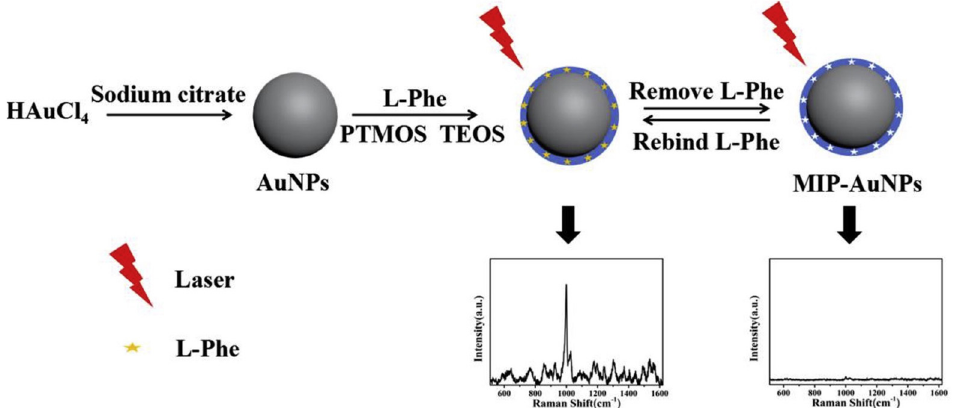
Figure 7. General scheme for the synthesis of the MIP@AuNPs, and SERS signal of MIP@AuNPs before and after the elution of the target molecule. Reproduced with permission from [73].